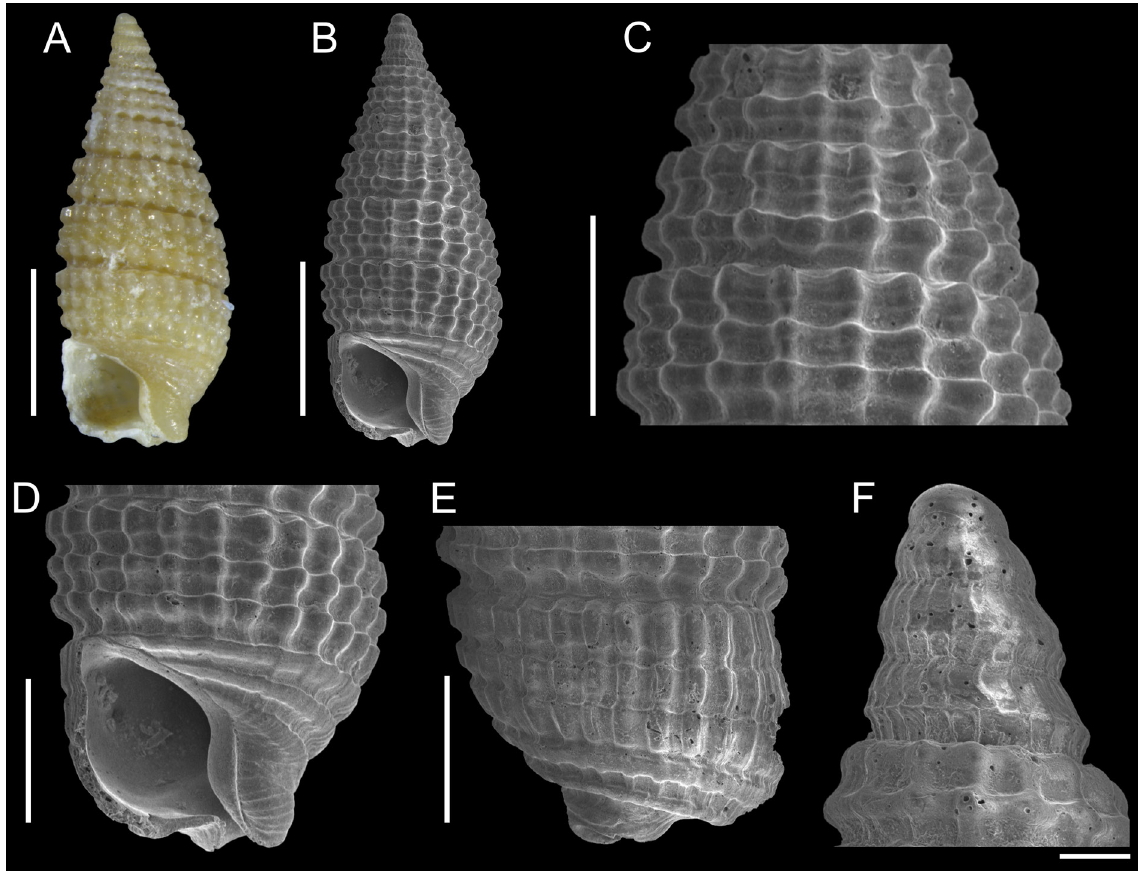
Fig. 12. Nanaphora sp. 1. A–F . MNRJ 35177*, 2.94 mm. Scale bars: A–B = 1 mm; C–E = 500 µm; F = 100